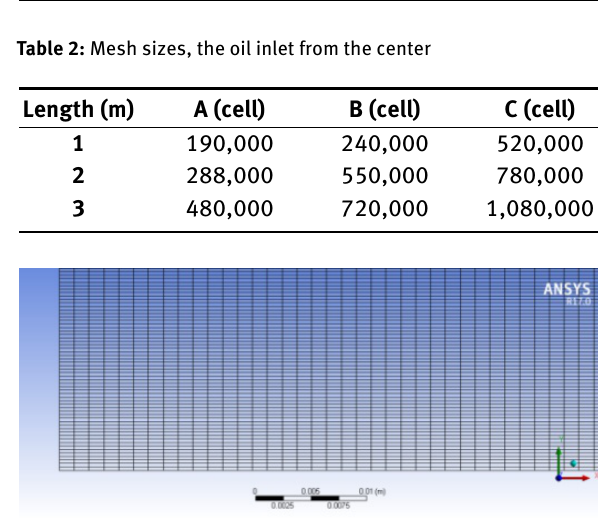
Figure 2: Structured and uniform mesh